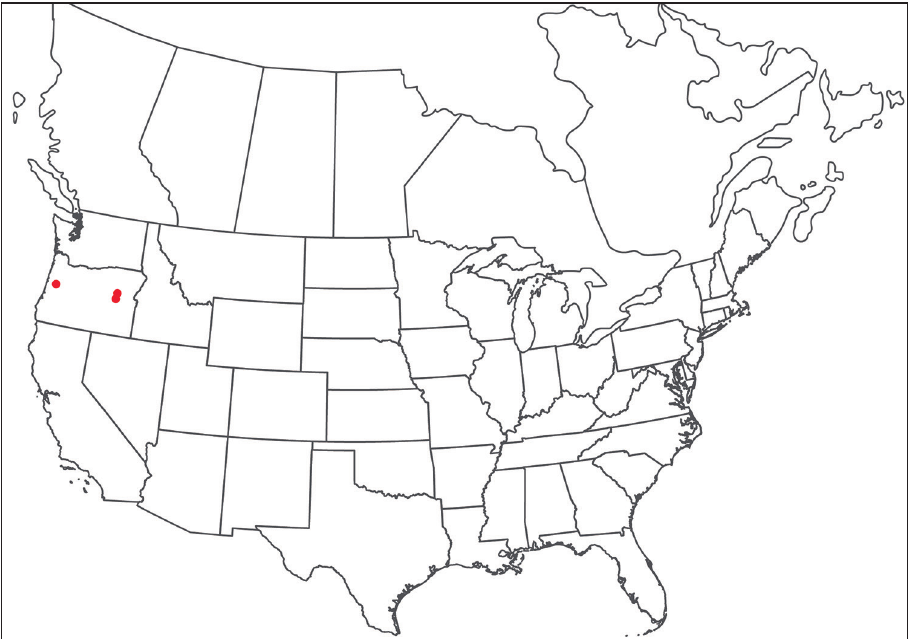
Figure 178. Torrenticola oregonensis sp. n.